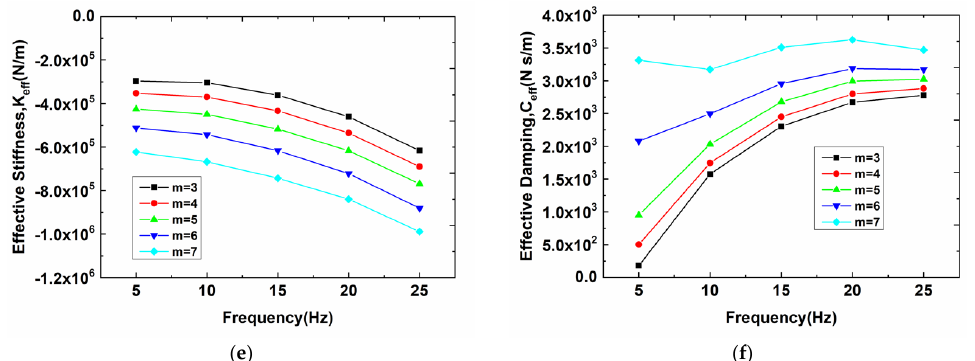
Figure 11. Direct stiffness K xx ( a ), direct damping C xx ( b ), cross-coupling stiffness K xy ( c ), cross- coupling damping C xy ( d ), effective stiffness K eff ( e ) and effective damping C eff ( f ) of the annular seal in Case 2 ( P = 4000 Pa).